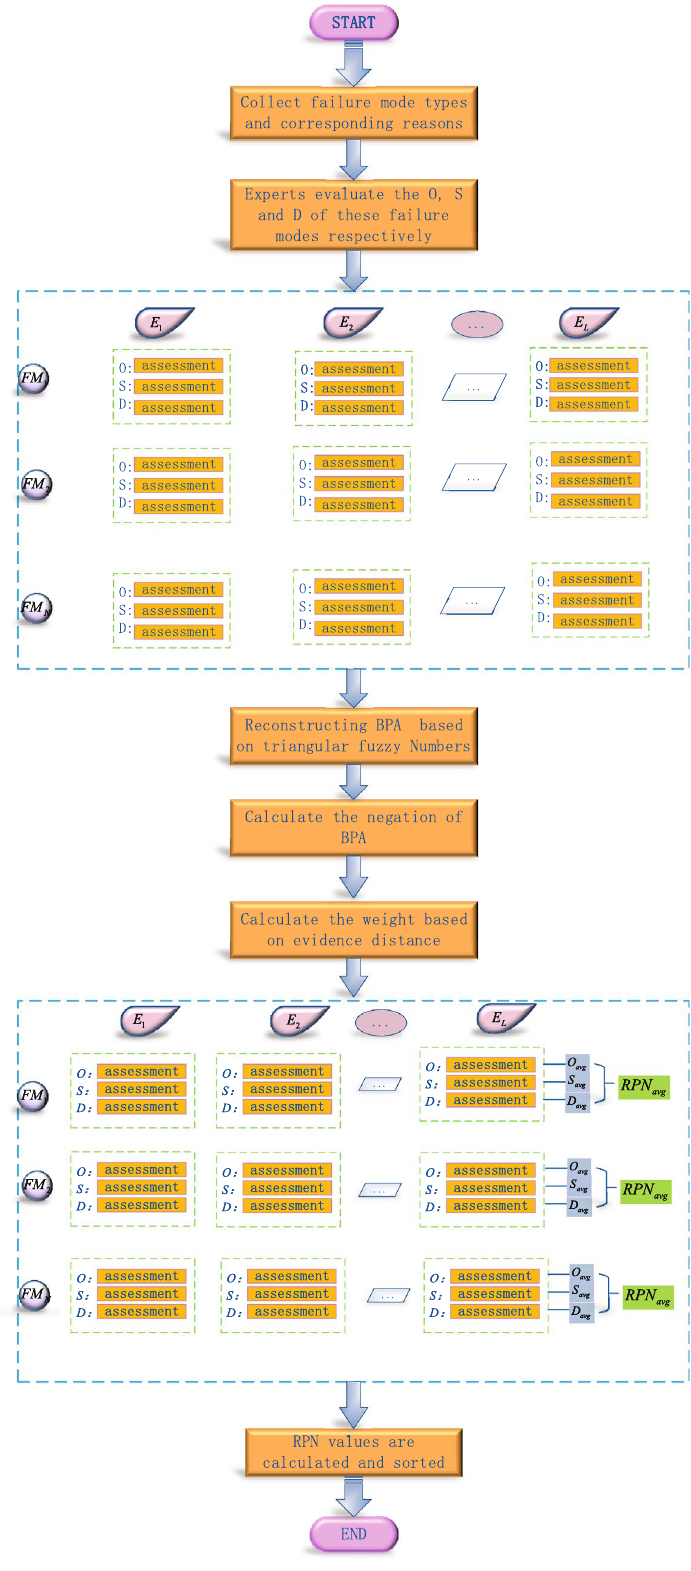
Figure 1. Flow chart of improved FMEA method based on triangular fuzzy numbers, the negation of BPAs and the evidence